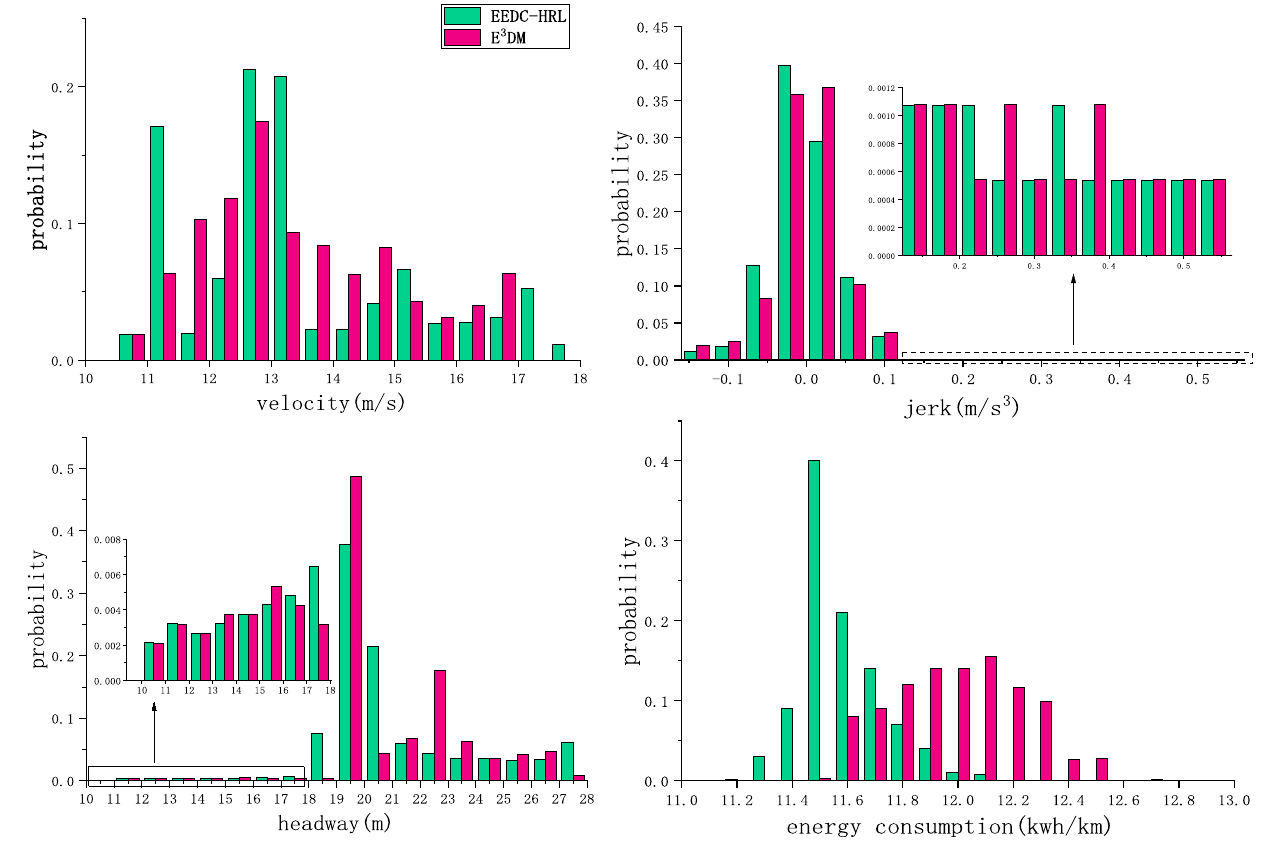
Figure A2 The data distribution of each performance indicator in the normal traf fi c fl